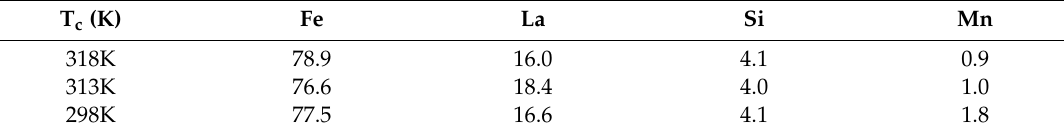
Table 1. Weight composition (wt%) of the tested samples.